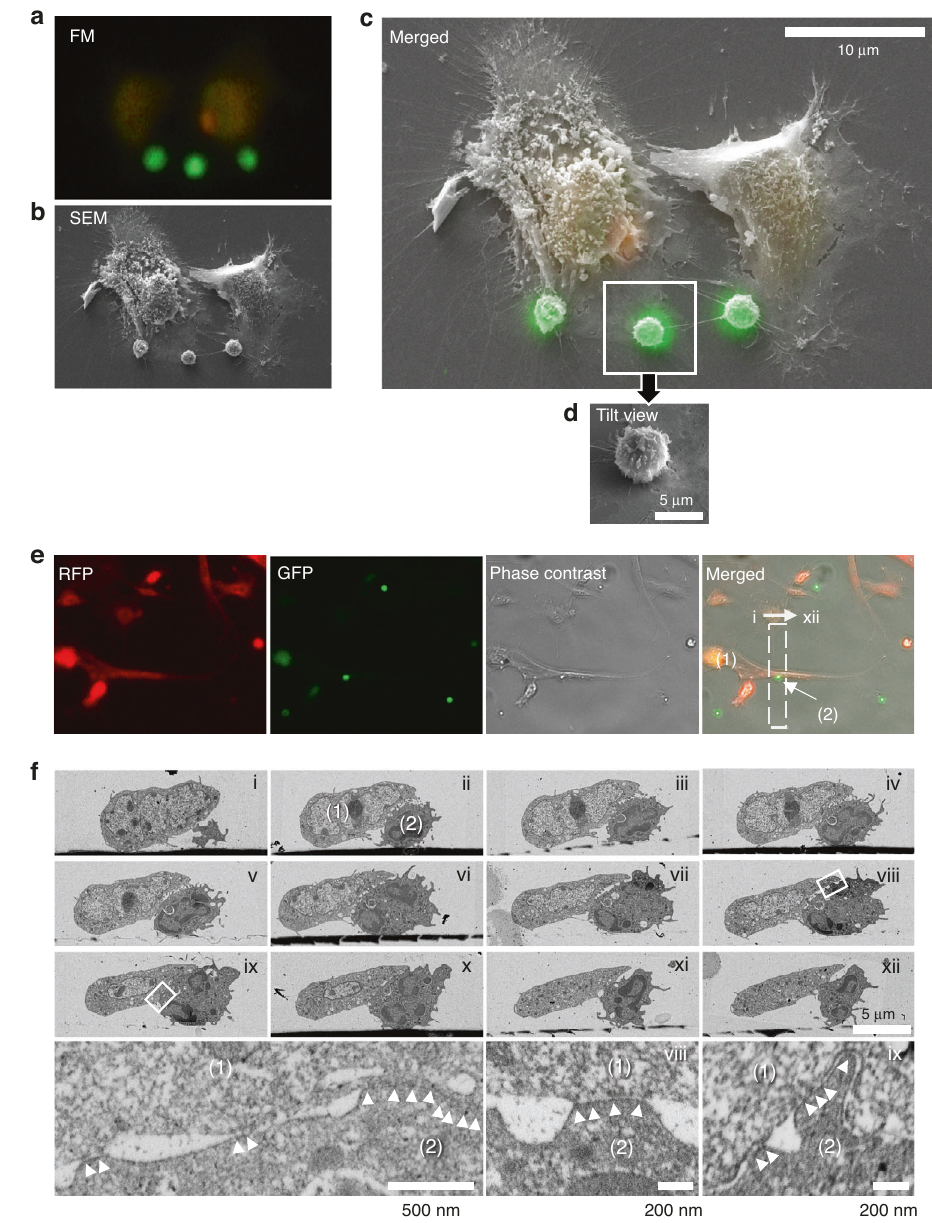
Fig. 3 Electron microscopic images demonstrate physical binding between M-MDSCs and osteoblasts. Murine M-MDSCs (CFSE; 1 × 10 5 cells) were added to adherent murine calvarial osteoblast (Vibrant ® DiD-NIR dye; orange; 1 × 10 5 cells) culture, followed by 30 min of incubation at 37 °C and washing of unbound cells with PBS. a – d Correlative light and electron microscopy (CLEM) images showing physical binding between osteoblasts (adherent cells) and M-MDSCs (green). Cells were imaged with a wide fi eld fl uorescence microscope and subsequently processed and imaged with a scanning electron microscope. Two images ( a , b ) were overlaid and are shown in (c) . Three M-MDSCs do not seem to physically bind to osteoblasts in fl uorescence microscopic images ( a ) but indeed bind to the cell body of osteoblasts ( b – d ). Inbox ( d ) shows the tilt view of the cell marked with a white box. FM, fl uorescence microscopy. SEM, scanning electron microscopy. ( e ) DiD-labeled osteoblasts and CFSE-labeled M-MDSCs were imaged using RFP and GFP channels, respectively, followed by merging with a phase-contrast microscopic image. One representative osteoblast (indicated by 1) and one representative M-MDSC (indicated by 2, in the dotted line box) were further imaged by backscattered electron (BSE)-SEM serial ultrathin sections (images from i to xii in Panel f ). f Serial ultrathin sections of the area indicated by the dotted line box in ( e ). Enlarged images of the part where two cells were attached. White arrowheads indicate cell adhesion regions. (1), osteoblasts. (2),